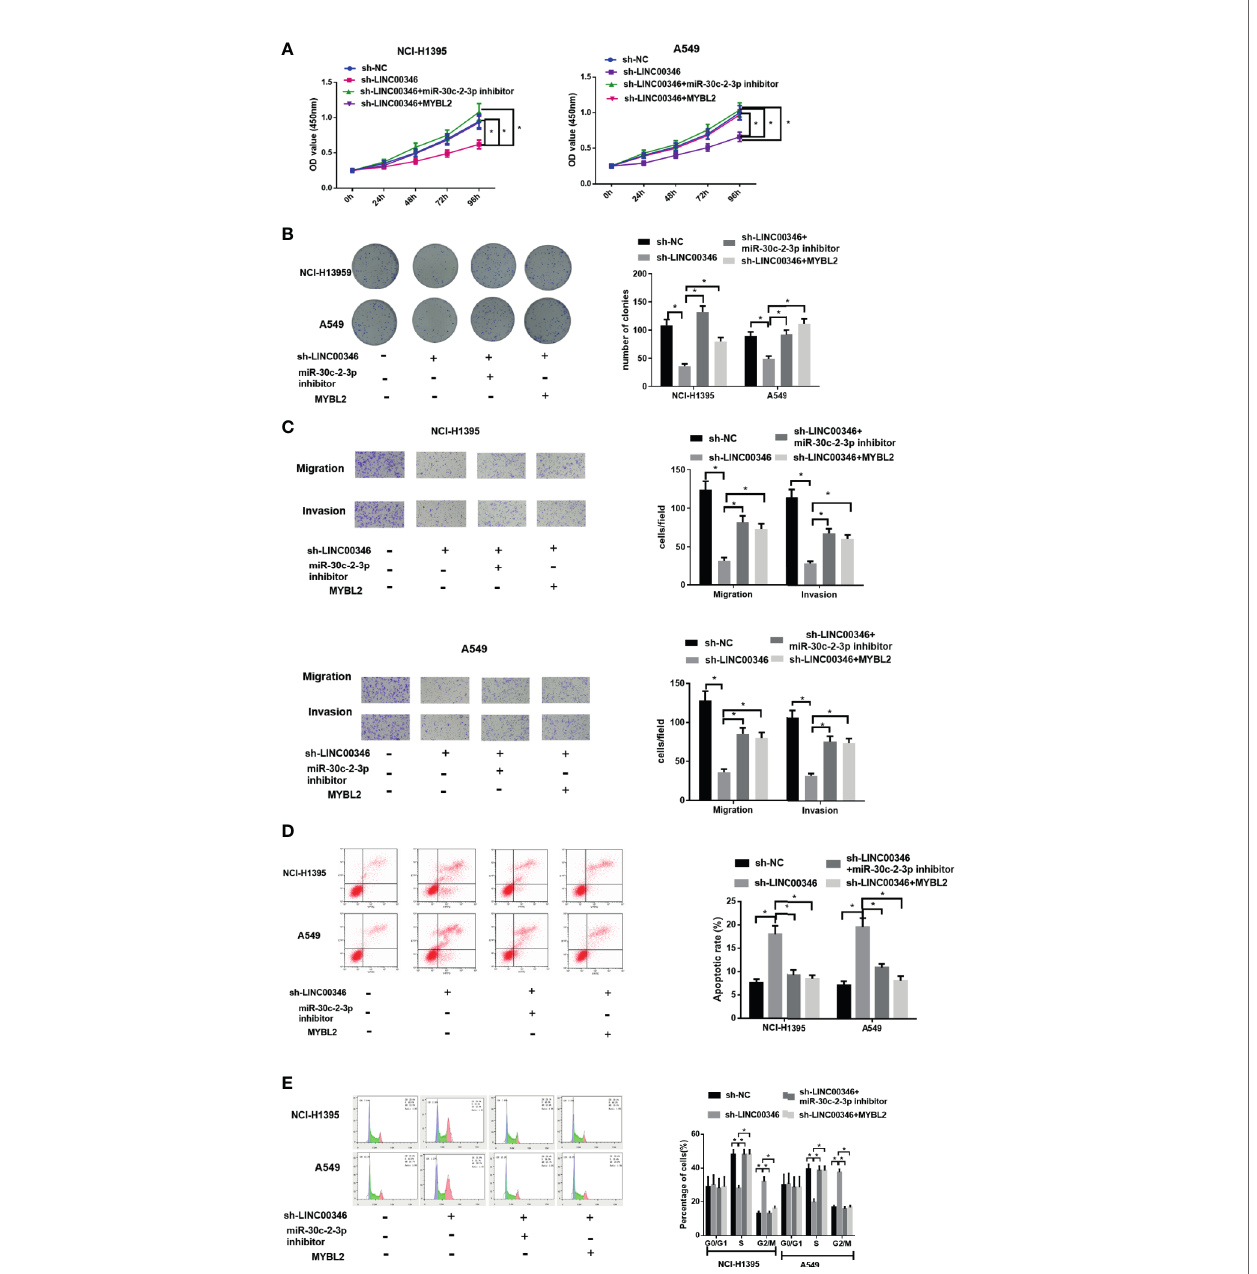
FIGURE 6 | LINC00346 promotes the growth of LUAD cells by regulating the miR-30c-2-3p/MYBL2 axis. (A) Cell proliferation, (B) colony formation ability, (C) migration and invasion (100×), (D) apoptosis and (E) cell cycle progression of NCI-H1395 and A549 cells were detected by CCK-8, colony formation, Transwell and FCM assays, respectively. * P <